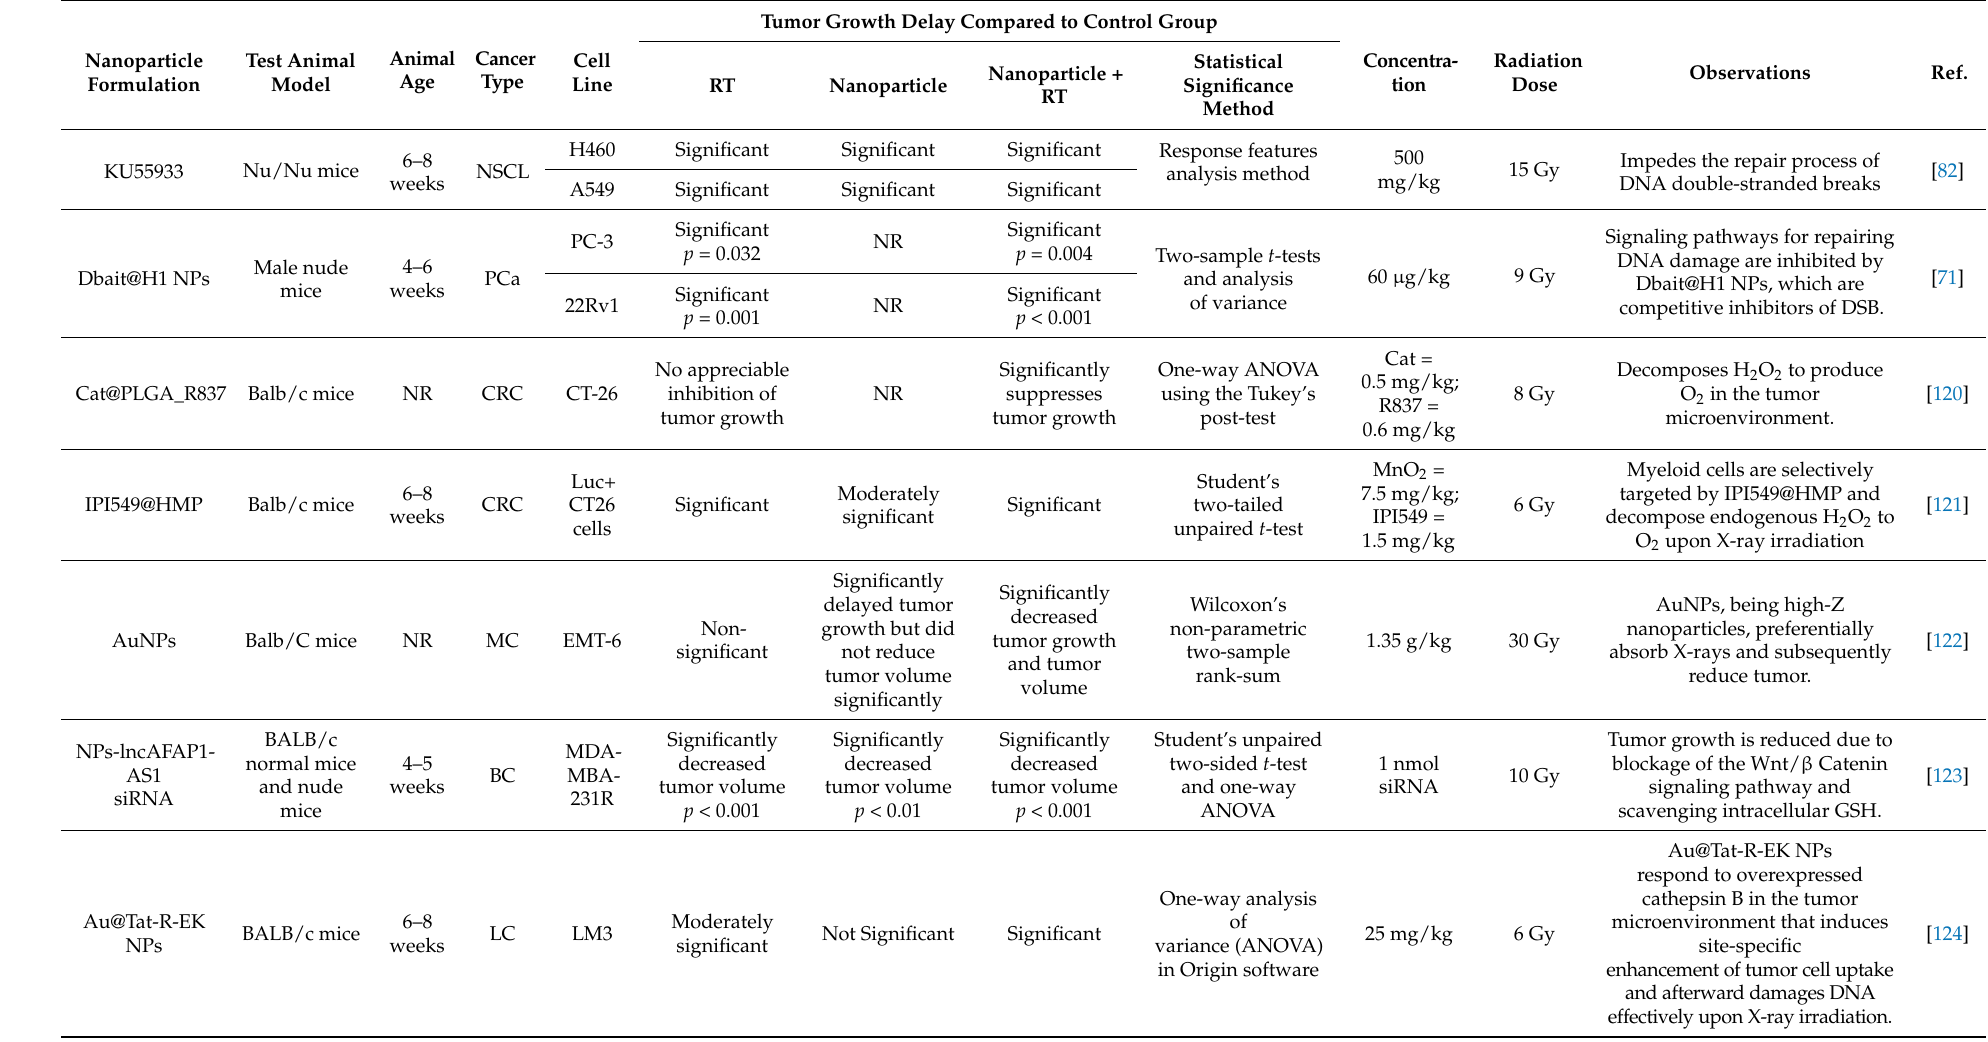
Table 1. In vivo effects of NP-based